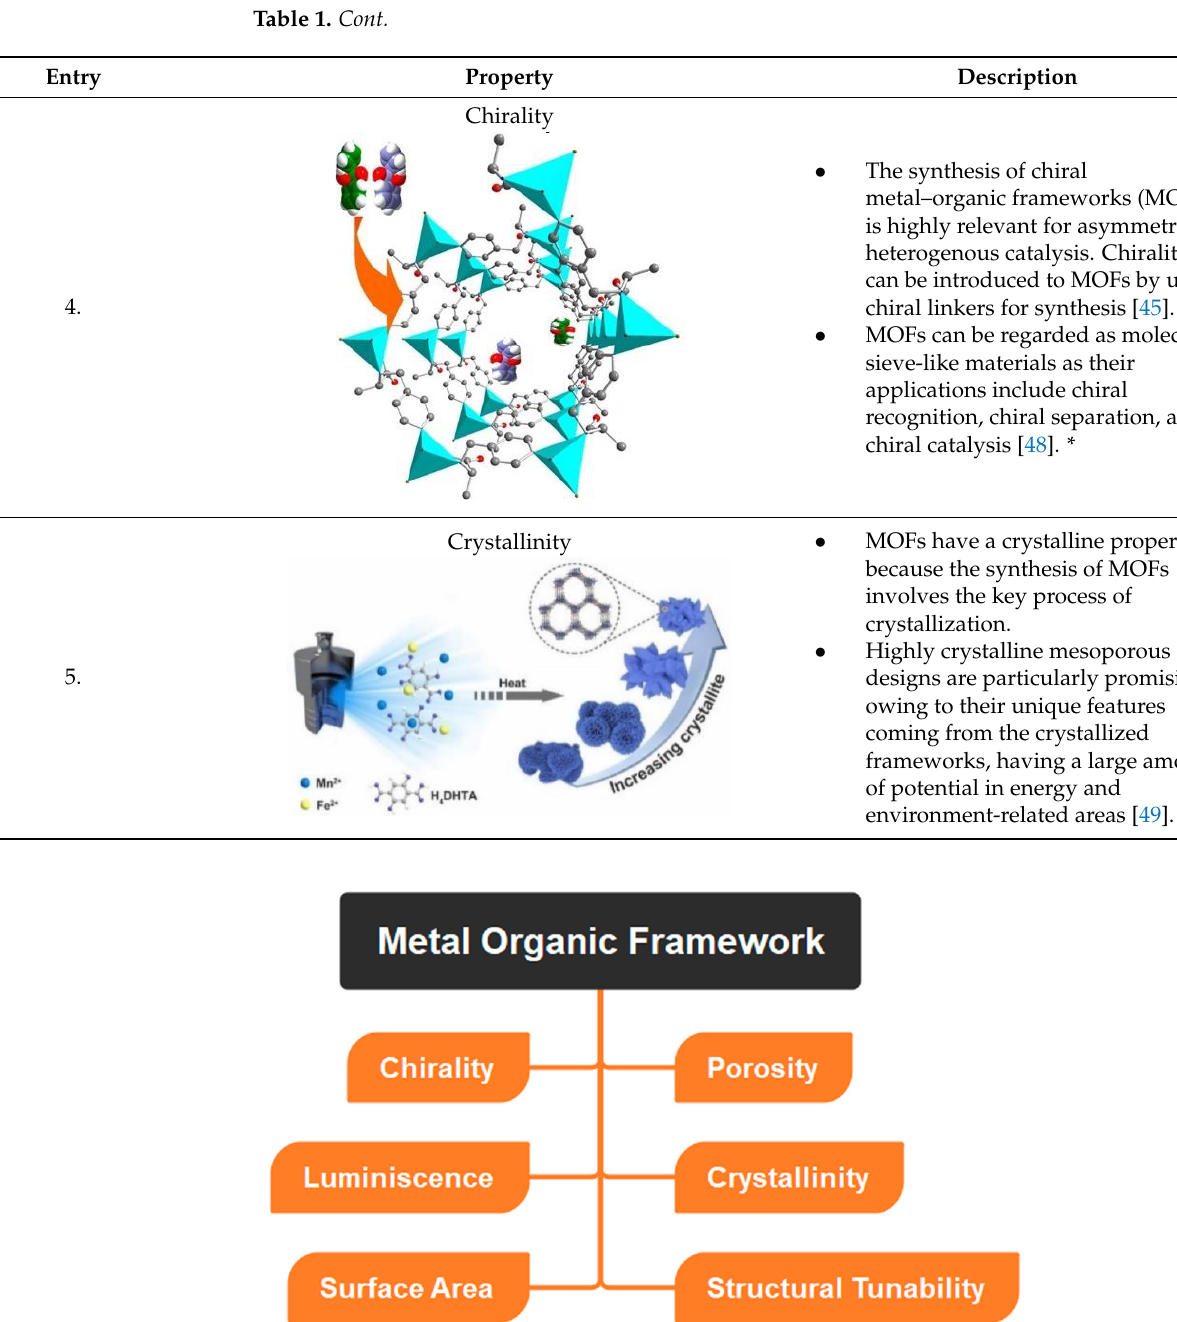
Figure 3. Depicting physicochemical properties of MOFs. Table 1. Physico-chemical properties of MOFs. * Reproduced from references with permission.